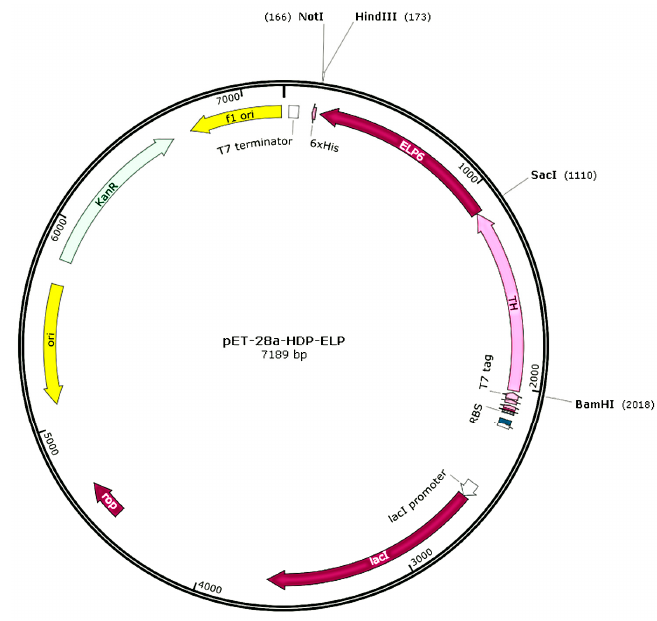
Figure 6. Schematic presentation of constructed vector for expression of HDP ‐ ELP.